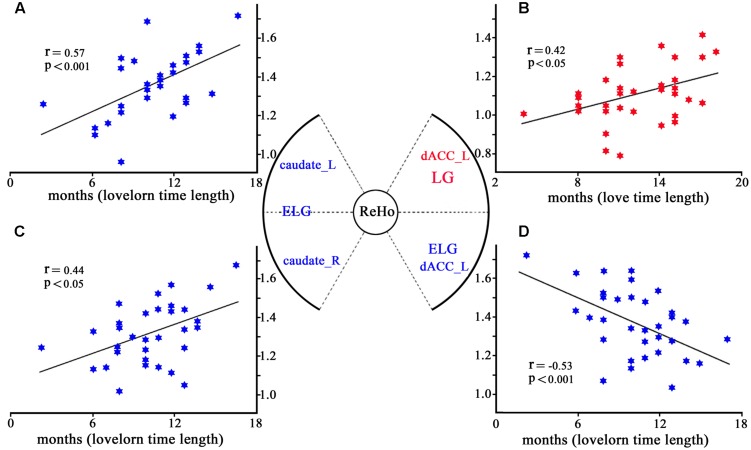
Correlation between ReHo and the length of time in-love (in LG) or the lovelorn duration since the breakup of romantic relationship (in ELG). (A) depicts ReHo in the left caudate nucleus (–18, 9, 24), which was significantly positively correlated with the length of time since the romantic relationship breakup in ELG; (B) shows ReHo in left dACC (–6,18,33), which was significantly negatively correlated with the length of time in love of LG; (C) demonstrates ReHo in the right caudate nucleus (18,12,18), which was significantly positively correlated with the length of time since the romantic relationship breakup in ELG; (D) shows ReHo of left dACC (–6,18,30), which was significantly positively correlated with the length of time since the romantic relationship breakup of ELG. *Coordinates in MNI space.